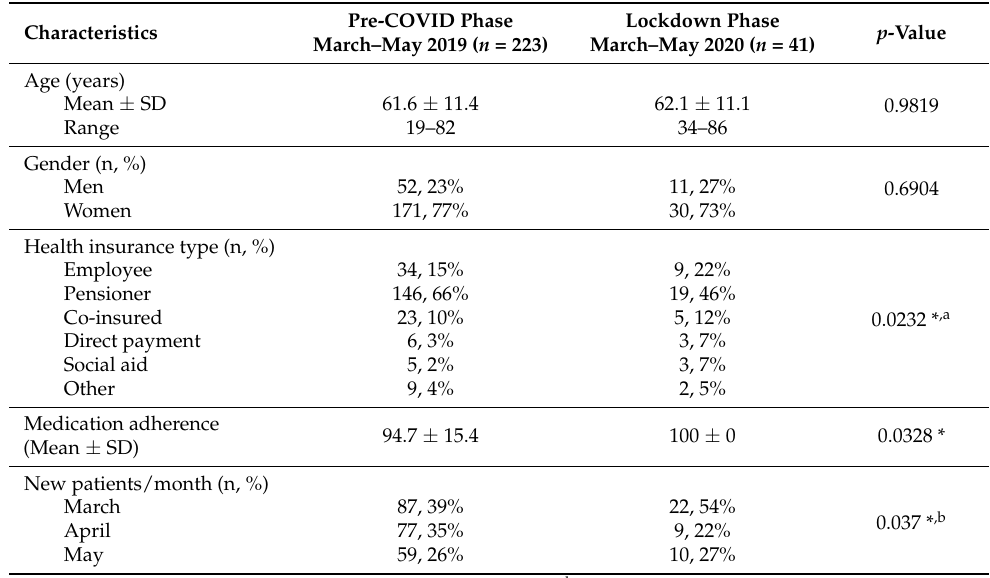
Table 1. Patient characteristics with comparison between pre-COVID phase and lockdown phase.